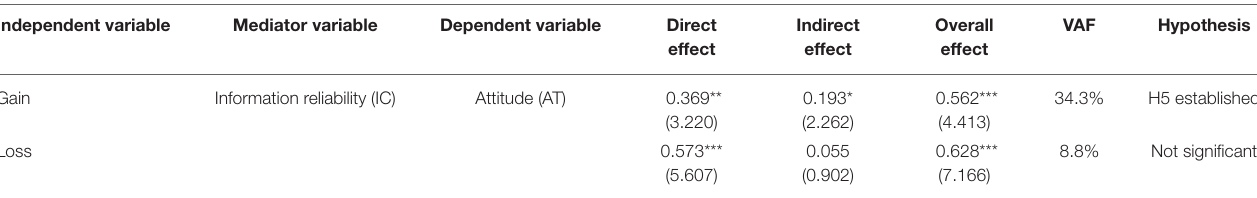
TABLE 4 | Intermediary effect test